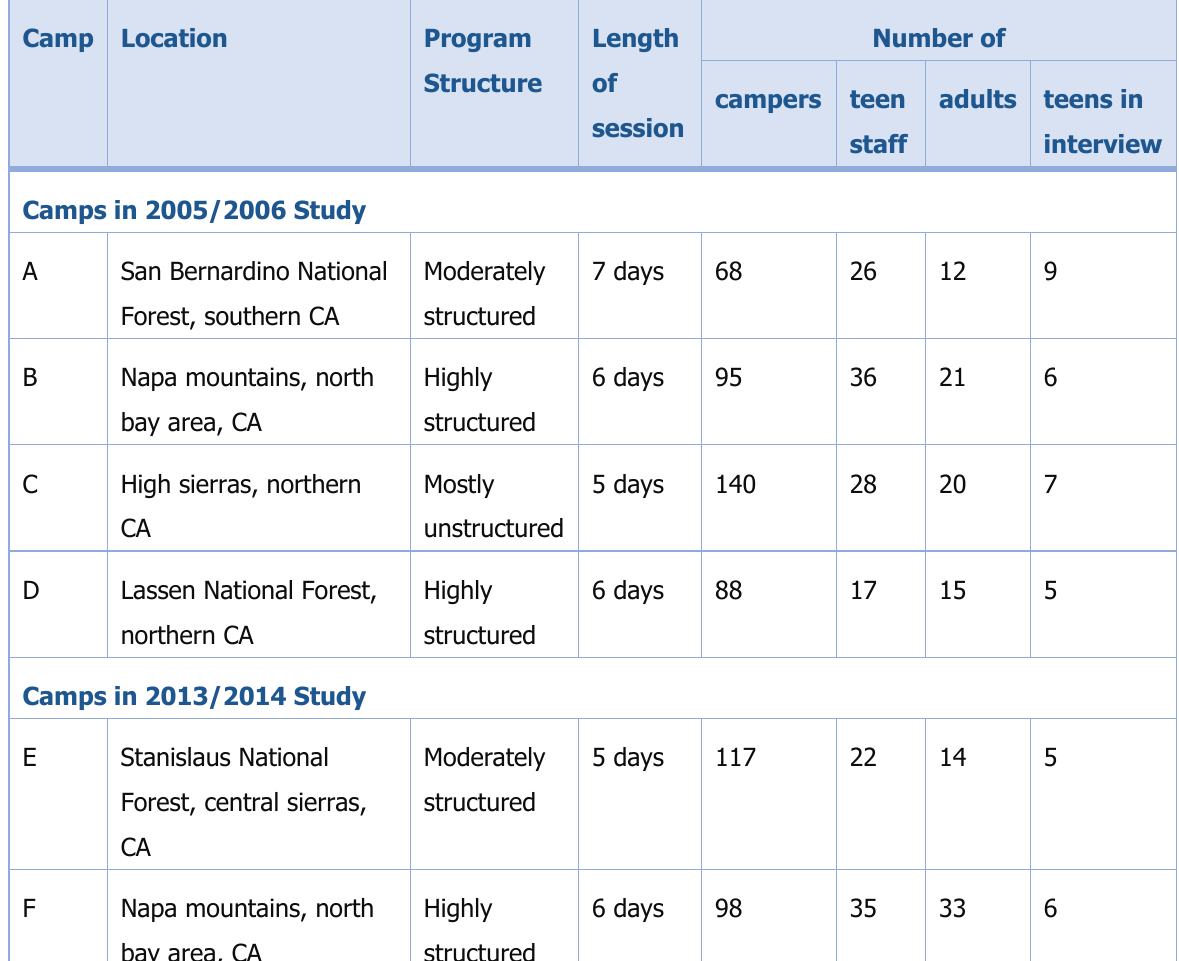
Table 1. Profiles of Camps Involved in California 4-H 2005/2006 and 2013/2014